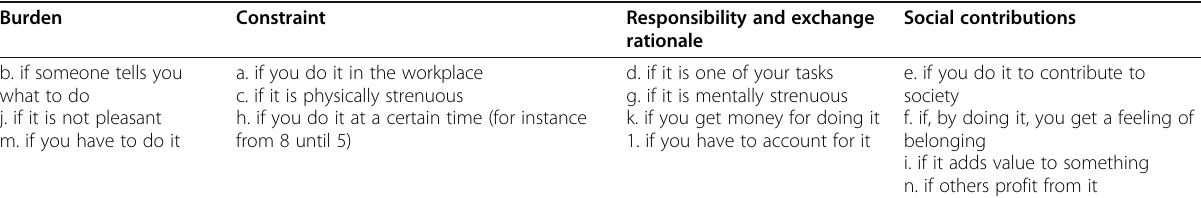
Table 1 Items used to define the concept of work Burden Constraint